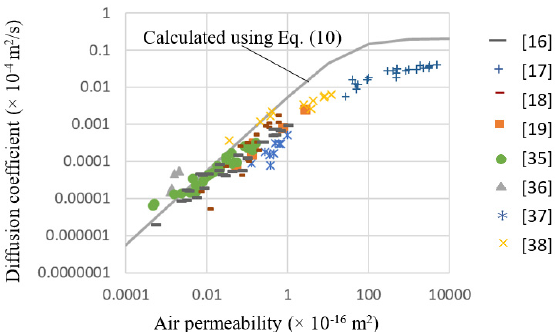
Figure 5. Relationship between the air diffusivity and permeability described by Eq. 10 with P 0 = 100 kPa. In the experiments, there was a point of a deviation from linearity at an air permeability of approximately 50 × 10 ‐ 16 m 2 . the boundary between the molecular and viscous flows.